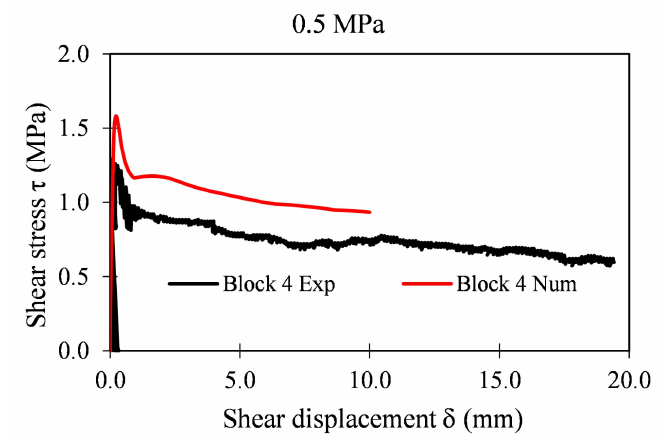
Figure 27. Shear stress evolution with displacement Exp–Num (Block